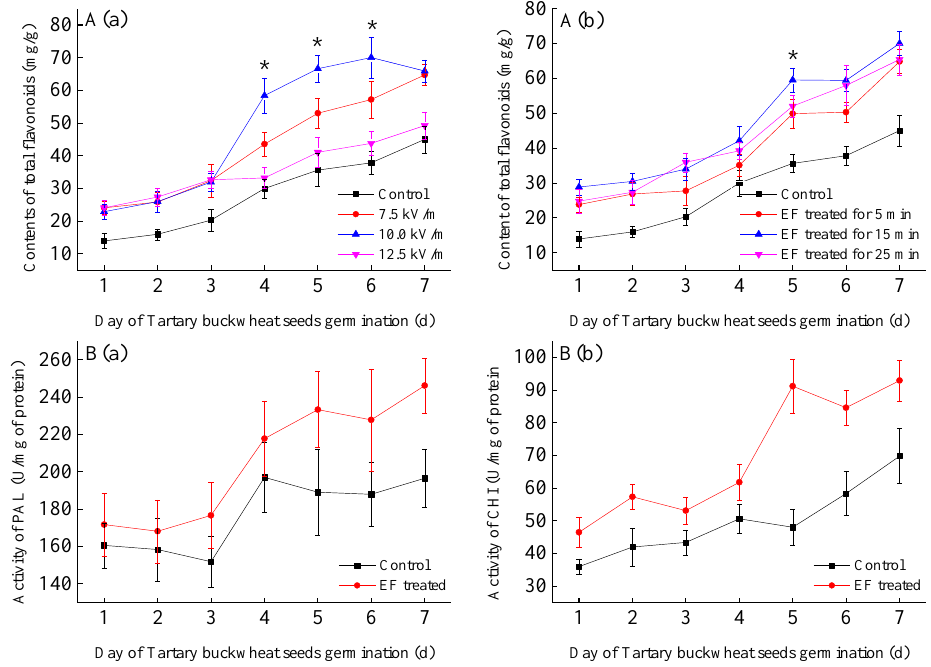
Figure 1. Total flavonoids in electric field (EF)-treated tartary buckwheat seeds ( A ). The e ff ects of di ff erent intensities (7.5–12.5 kV / m) ( a ) and EF stimulation times (5–25 min) ( b ) were respectively measured and compared. One way analysis of variance (ANOVA) with Least-Significant Di ff erence (LSD) was used to determine significant di ff erences with respect to control and EF-treated groups. *, p < 0.05. The seeds untreated were control. ( B ) Enzyme activities of phenylalanine ammonia lyase (PAL) ( a ) and chalcone isomerase (CHI) ( b ). EF (10 kV / m, 15 min) significantly improved the